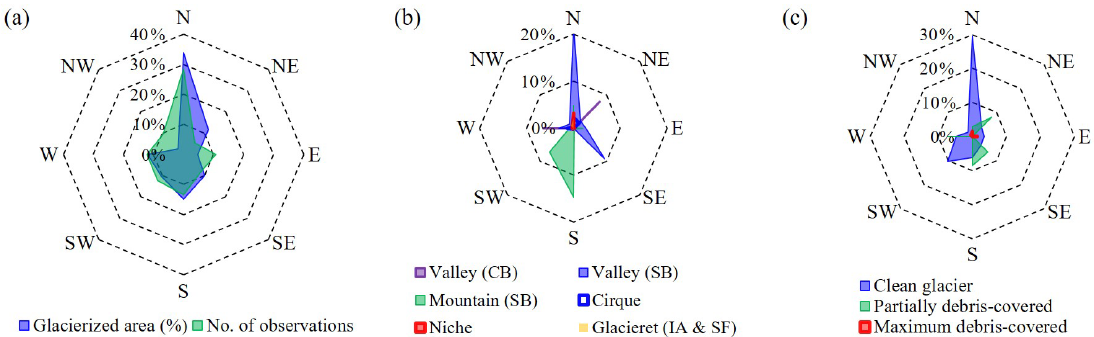
Figure 8. Distribution of the glaciers (74) according to aspect in the CCW based on the Sentinel-2A MSI (26 November 2018) and SRTM DEM. (a) Glacier frequency distribution and total glacierized area in percent; (b) glacierized area (%) according to morphological types; (c) glacierized area (%) in relation to debris-covered types. All the data are as percentages (%), and on average, the glaciers in this watershed are predominantly oriented towards the N (0 ◦ ) followed by towards the S (180 ◦ ).